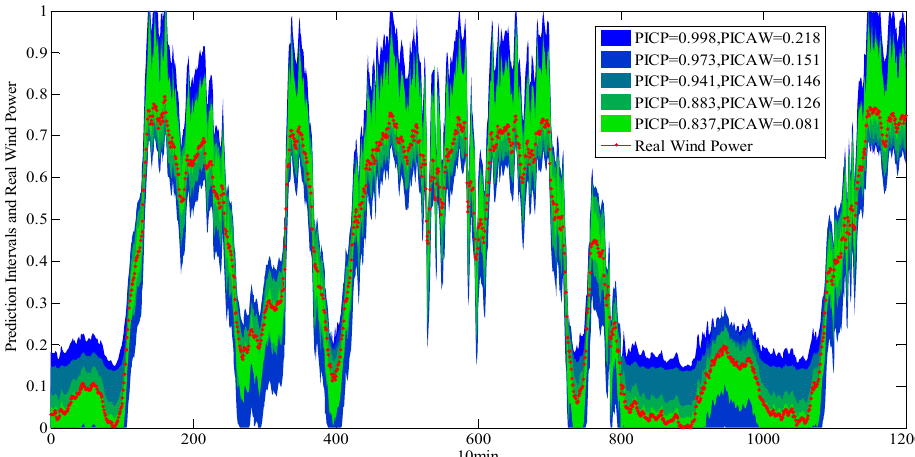
Figure 6. Prediction intervals with PIMOC based on MOABC. PIMOC: PIs’ multi-objective optimization criteria; MOABC: multi-objective artificial bee colony; PICAW: PIs covered-normalized average width; PICP: PI coverage probability.